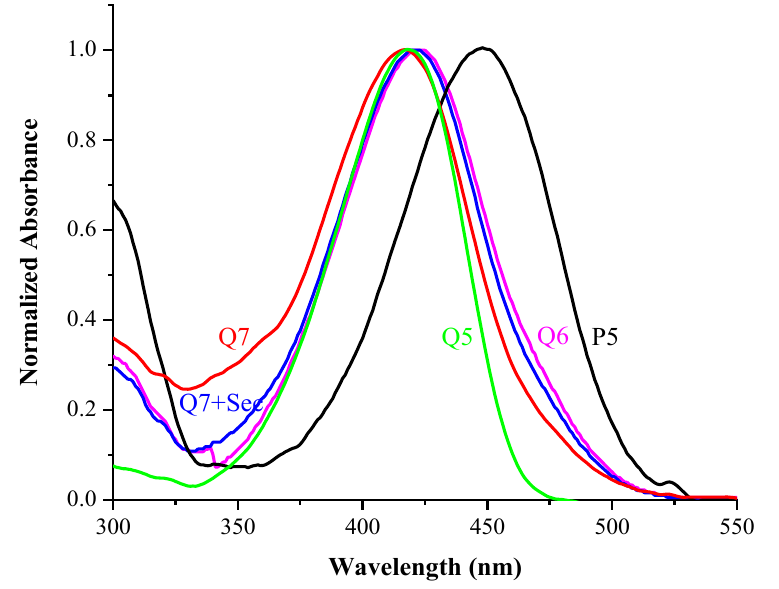
Figure 1. Normalized absorption curve of 1 µ M P5 (black), Q5 (green), Q6 (pink), Q7 (red), and Q7 reacting with 10 µ M Sec (blue) in DMSO / PBS = 1:99 ( v / v ).